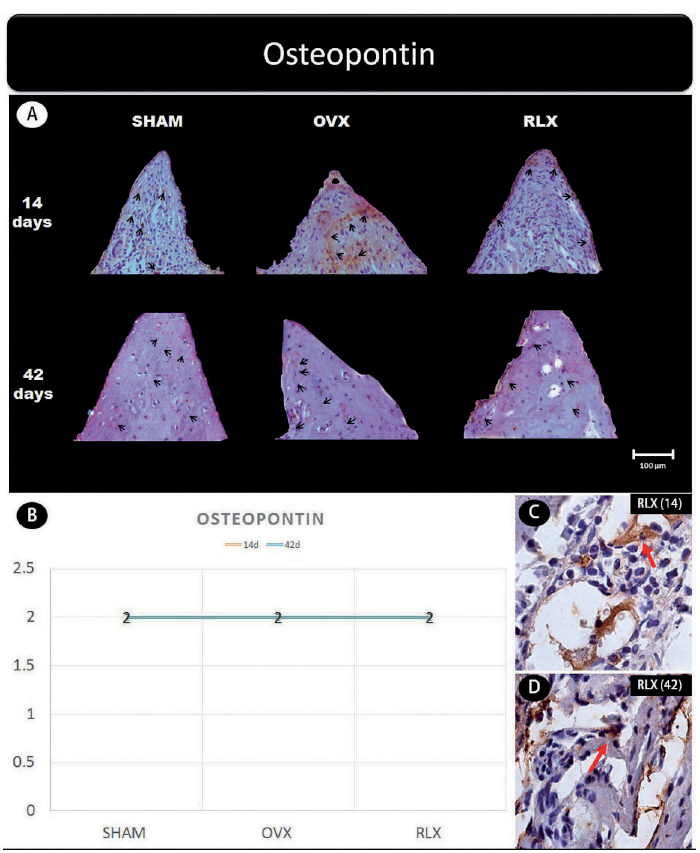
Figure 4- (A) Photomicrographs in a higher original objective (x40) of the different groups (SHAM, OVX, and RLX) and periods (14 and 42 days), in which is possible to observe an increased area of diaminobenzidine-stained cells (brown areas) around the peri-implant bone where the biomarker osteopontin were intense, represented by black arrows, denoting an improvement in the bone mineralization; (B) The chart shows the scores submitted to the Kappa test, in which the index was adjusted to >0.8, representing expression of osteopontin among the groups and in both periods; (C and D) Photomicrographs in a higher original objective (x100) about the 14 and 42 days of peri- implant bone healing from RLX group showing a moderate labeling of the biomarker osteopontin represented by red